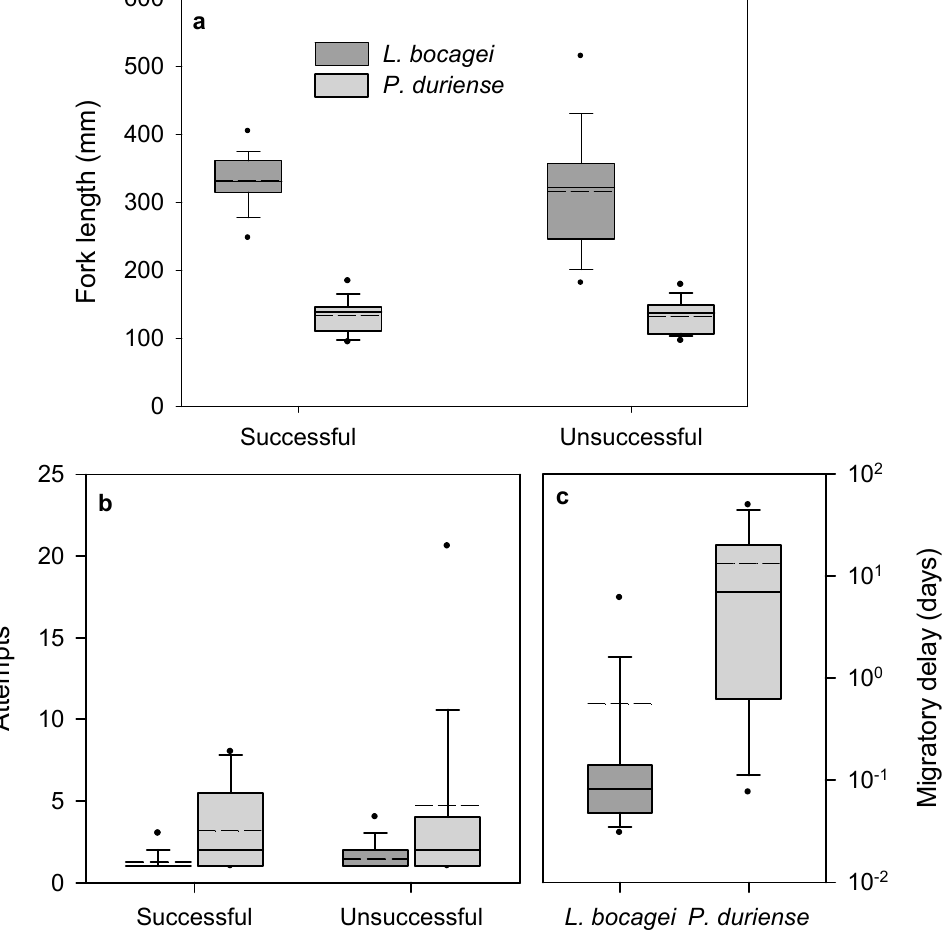
Figure 1. ( a ) Size of fish recorded at the antennas system; ( b ) number of attempts, and ( c ) and migratory delay (calculated as the time between first record at bottom antenna and the last record at the top antenna). Box represents the 50% of data (from 25th to 75th percentiles), whisker caps represent 10th and 90th percentiles, and points represents 5th and 95th percentiles. The short dashed line represents the mean.